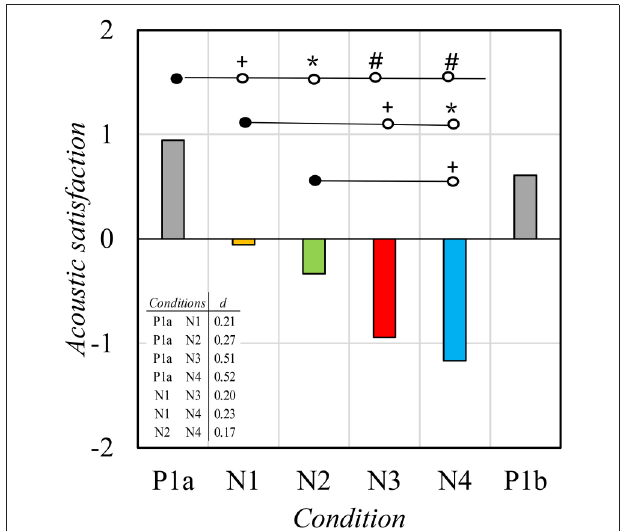
FIGURE 5 | The mean satisfaction with the noise and acoustic environment of the office as a whole. Scale: − 2 very dissatisfied; + 2 very satisfied. Levels of